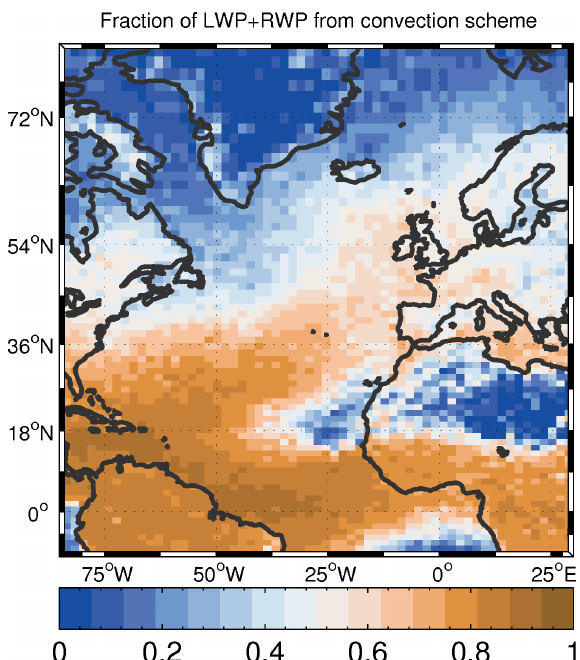
Figure D4. Ratio of the TLWP (where TLWP is the sum of LWP and RWP) from the model convection scheme to the total (from the convection and large-scale scheme) TLWP. The RWP from the convection scheme is calculated from the convective rain rate diagnostic by assuming a raindrop size distribution and fall speed relationship (see Furtado et al., 2016, for